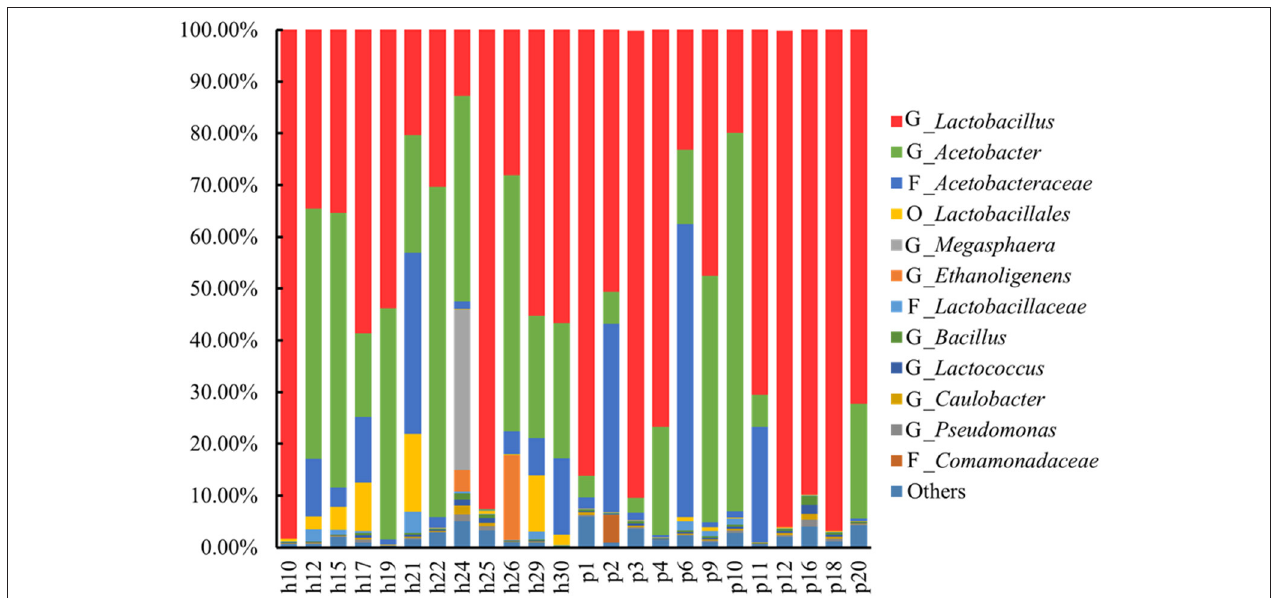
FIGURE 1 | Abundance of the top 12 abundant operational taxonomic units (OTUs) among the Suanzhou samples. OTUs with the abundance < 0.10% were not included in this diagram. G: OTUs at the genus level. F: OTUs at the family level. O: OTUs at the order level. Others: all OTUs with the abundance ≥ 0.10% were included. In summary, h10 with 0.10% Streptophyta (order); h12 with 0.10% Psychrobacter and 0.10% Clostridium ; h15 with 0.10% Psychrobacter and 0.3% Streptophyta (order); h17 with 0.30% Psychrobacter , 0.10% Micrococcaceae , 0.10% Phenylobacterium , and 0.10% Methylobacteriaceae (family); h21 with 0.20% Psychrobacter , 0.10% Micrococcaceae (family), 0.10% Phenylobacterium , 0.10% Bacteroides , and 0.30% Bacteroidales (order); h22 with 0.10% Psychrobacter , and 2.60% Gluconacetobacter ; h24 with 1.30% Psychrobacter , 0.20% Micrococcaceae (family); 0.5% Phenylobacterium , 0.40% Methylobacteriaceae (family),